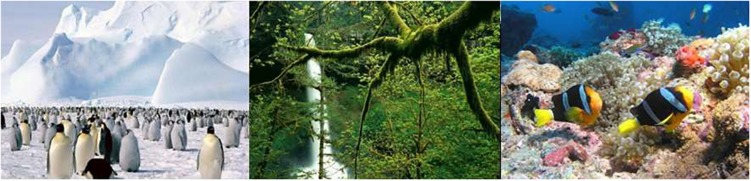
Some of the images of natural environments used in the emotional attribution test (Sánchez et al., 2012).